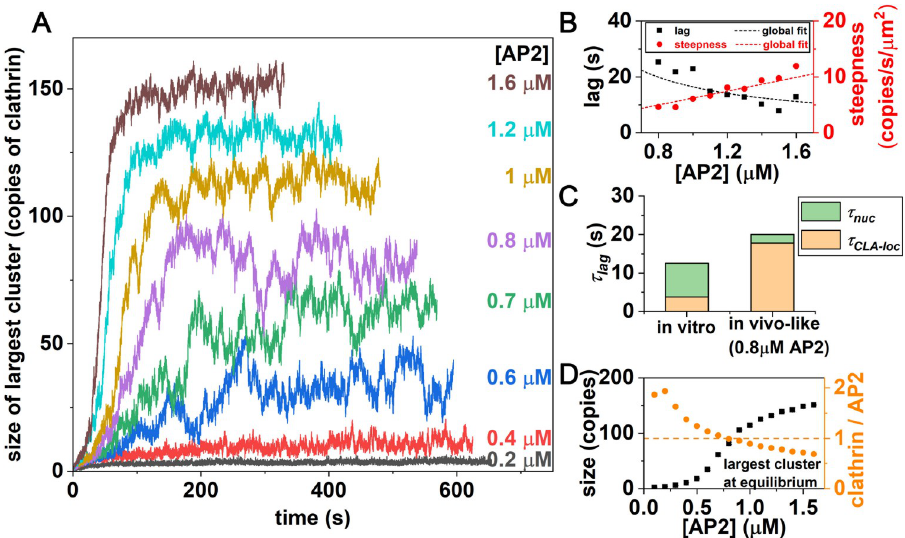
Fig 4. Clathrin lattices at physiologic-like geometries fail to assemble until adaptor concentration reaches 0.6 μ M. (A) Kinetics of the largest clathrin lattice assembly is faster and reaches larger sizes with increasing adaptor concentration. All simulations have 0.65 μ M clathrin. (B) Lag times and steepness of initial growth determined from simulation (black and red dots, respectively) follow the theoretical expressions of Eq 2 and Eq 3 relatively well. We excluded the low concentrations where the kinetics is not well-described by the lag and exponential growth model of Eq 1. (C) Lag times are typically slower in these geometrically physiologic-like simulations and rate-limited by localization of clathrin to a membrane (term 1 in Eq 2) with far fewer adaptor binding sites than in vitro . (D) The size of the largest lattices increases with increasing adaptor concentration, transitioning from small to large lattices at ~0.8 μ M (black squares). At this point, the stoichiometry of clathrin:adaptor has reached 1:1 (orange circles).